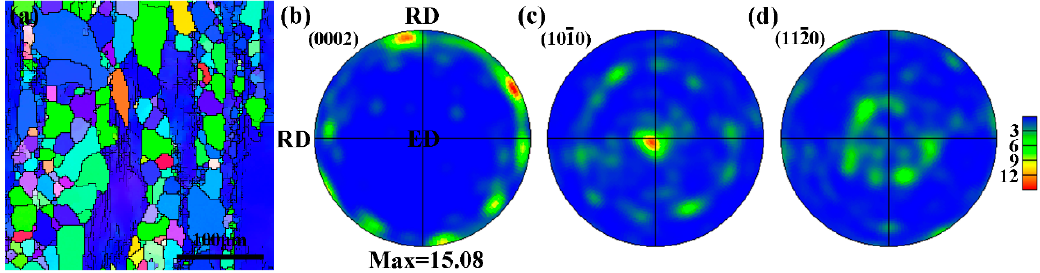
_ _ _ _ _ _ 10), ( d ) (112 0) pole 10), ( d ) (112 0) pole 010), ( d ) (11 2 0) pole